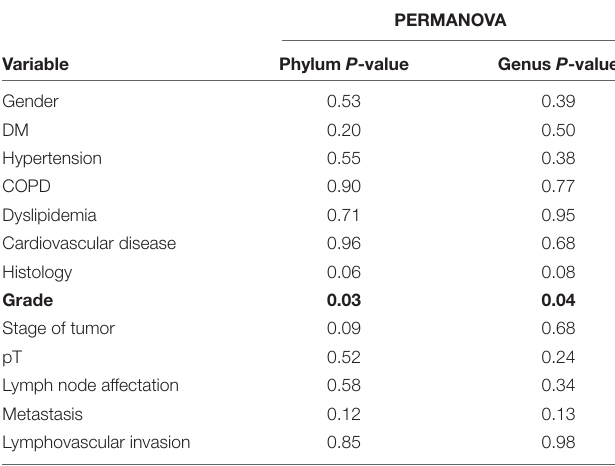
TABLE 4 | Results of the permutational multivariate analysis of variance (PERMANOVA) of the clinicopathological variables.